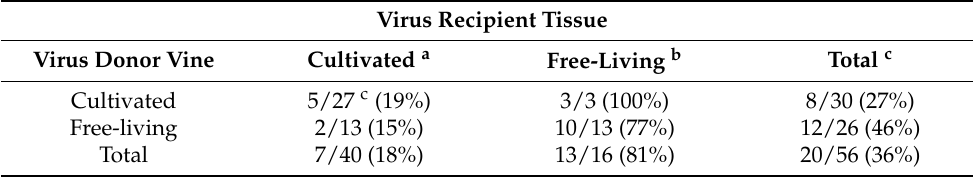
Table 2. Transmission of grapevine red blotch virus (GRBV) by Spissistilus festinus from and to Vitis californica hybrid vines and to and from ‘Cabernet franc’